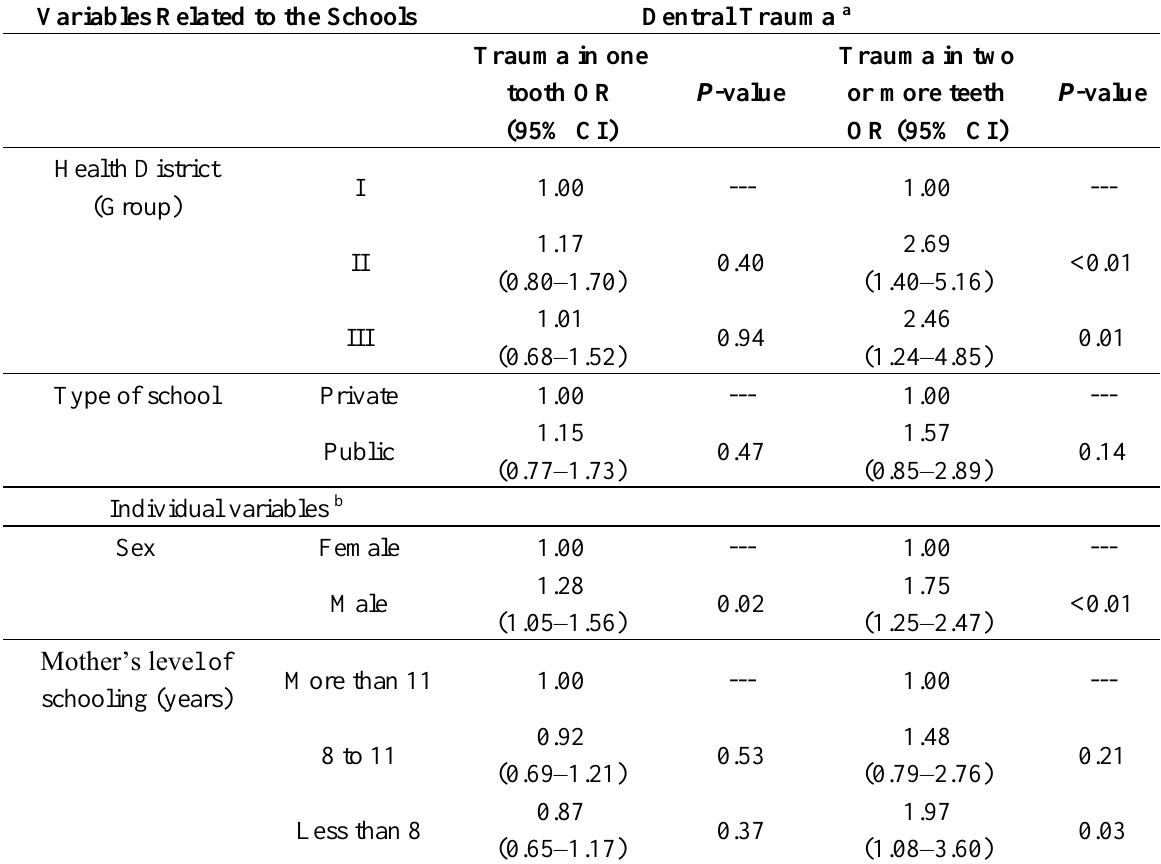
Table 3. Adjusted multinomial logistic regression analysis for the association between dental trauma and individual and school related